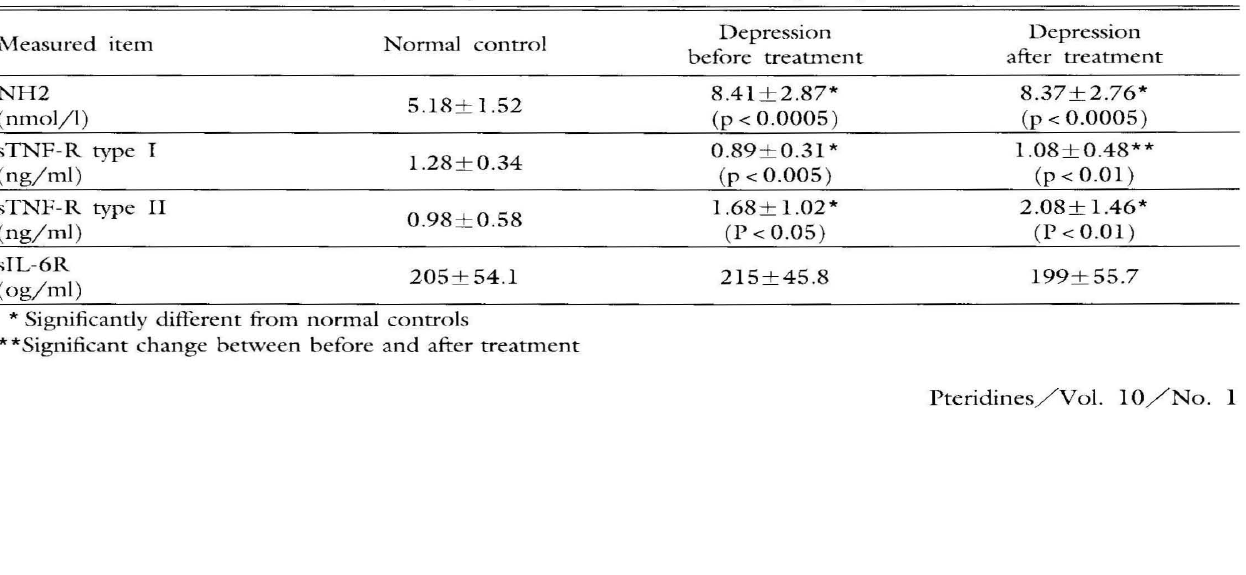
Table 1. Serum concentrations of dihydroneopterin and soluble cytokine receptors (mean ±SD ) Measured